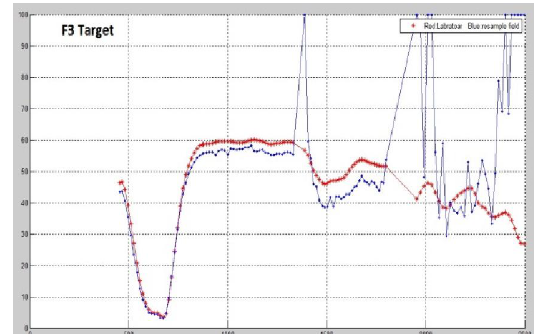
Figure 2. Laboratory (red) and resample field (blue) spectra of the subpixel target